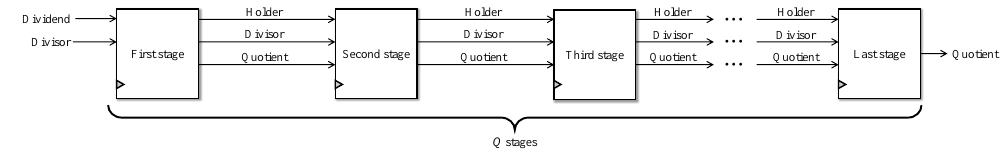
Figure A2. Datapath of the parallel